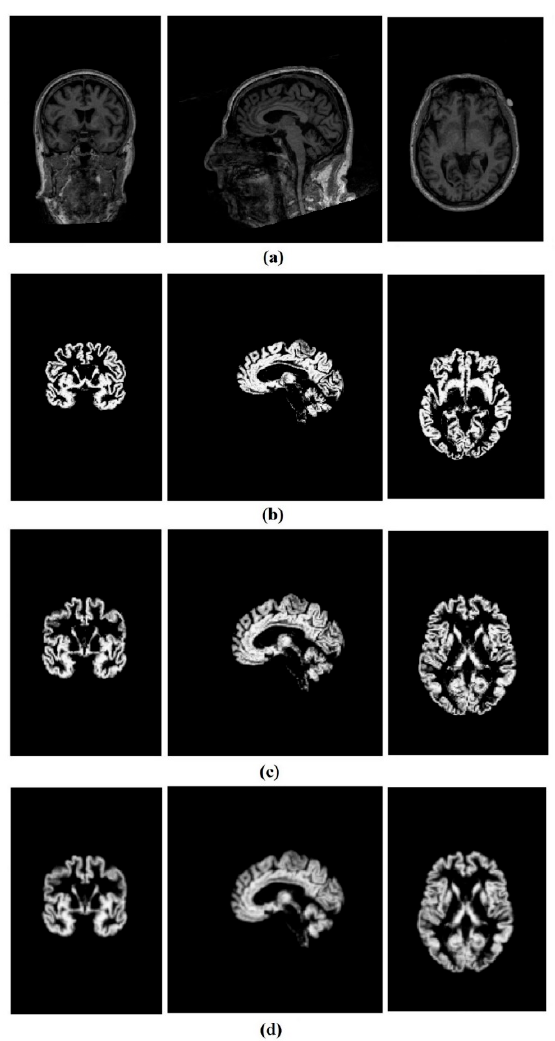
Figure 1. A control healthy subject’s MRI, ( a ) from left to right sagittal, coronal and axial view, ( b ). gray matter, ( c ). gray matter after normalization, ( d ). gray matter after smoothing.